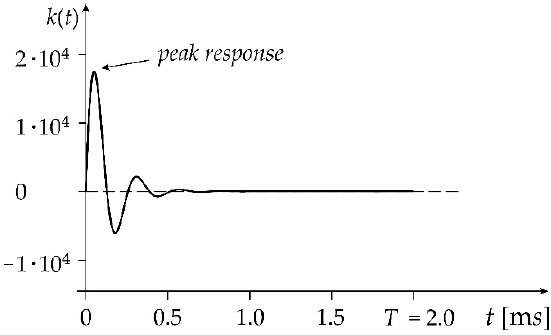
Figure 7. Impulse responses 𝑘(𝑡) calculated based on Equation (14).